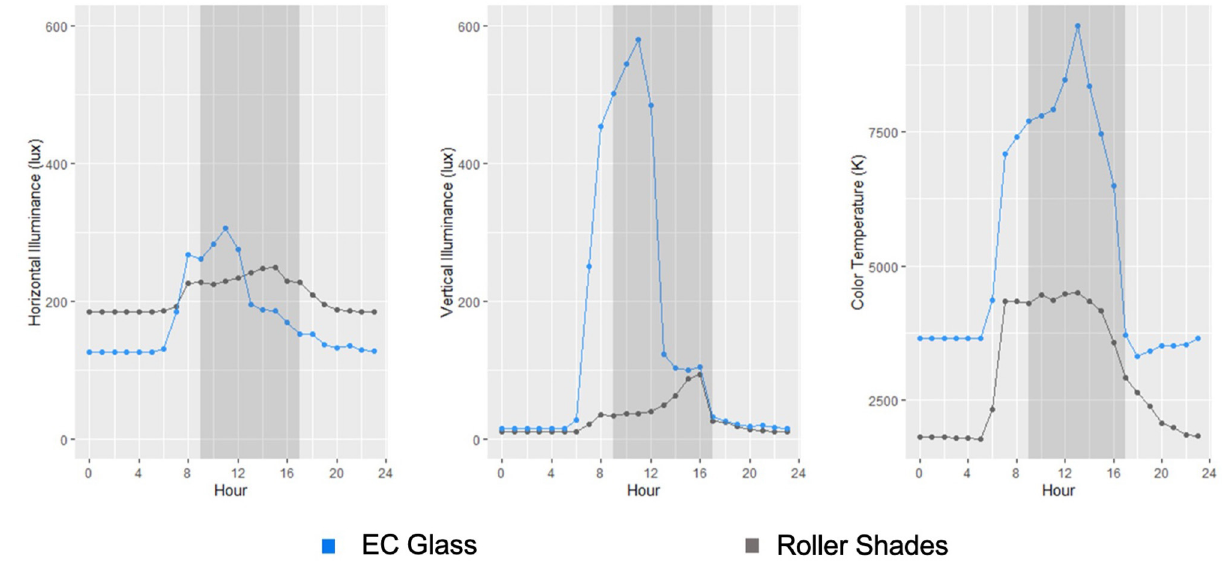
FIGURE 3 | Mean hourly light conditions in the two study conditions: horizontal illuminance in lux (left), vertical illuminance in lux (middle), and correlated color temperature in Kelvin (right). exercise and use of any medications or supplements, as well as an open-ended comment section for participants to note any extenuating